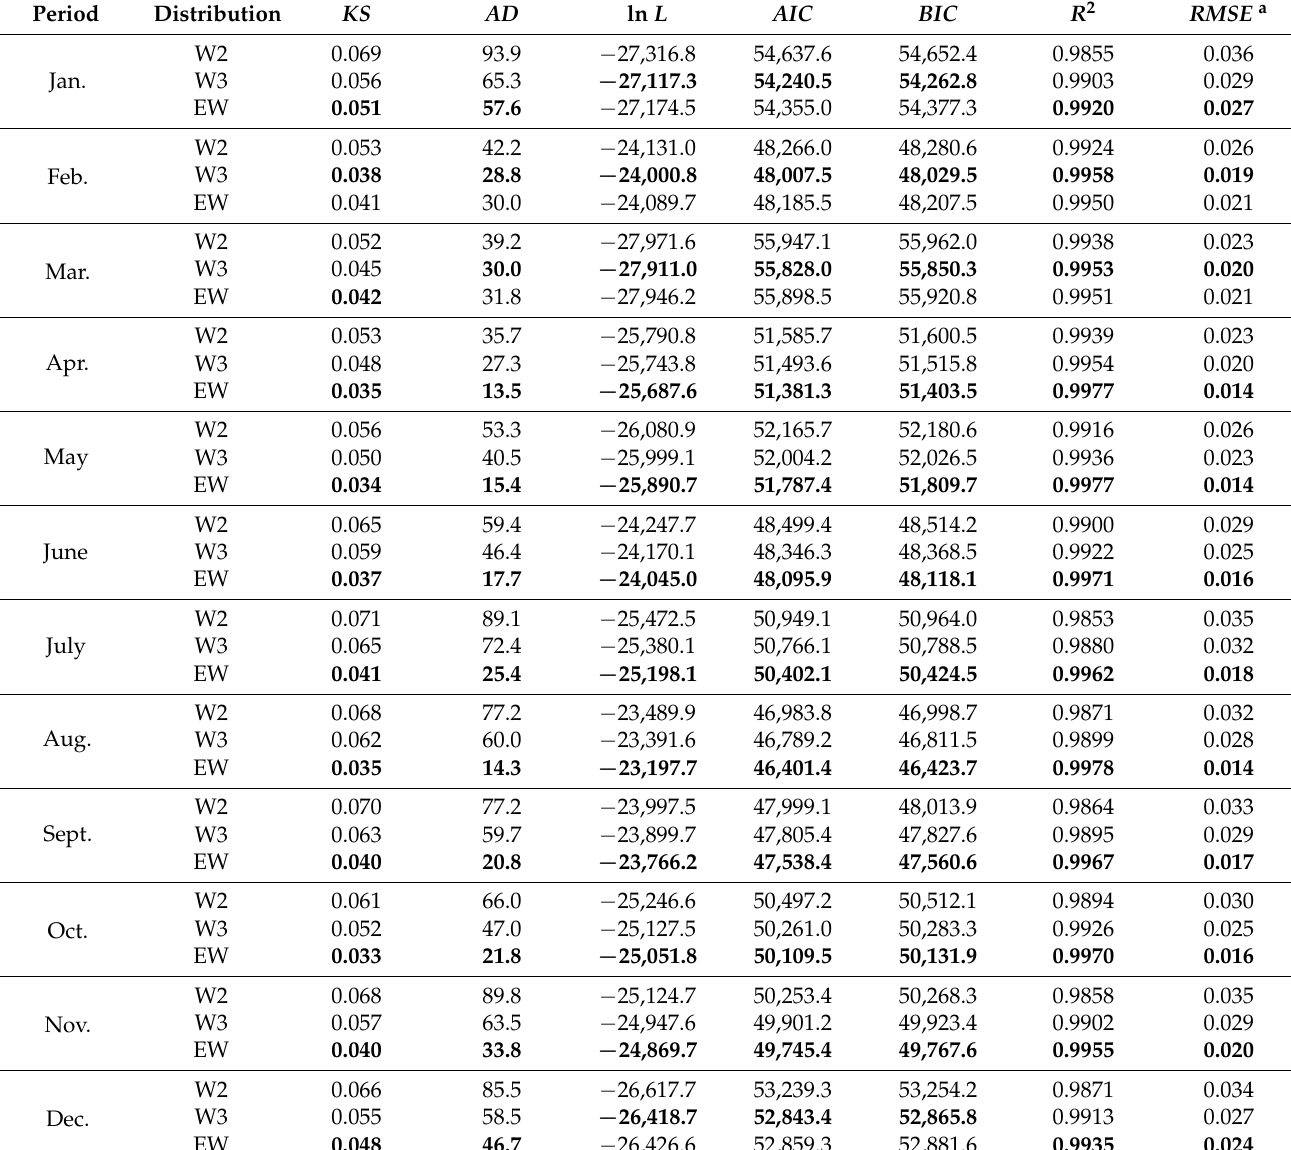
Table 8. The GOF tests and model selection criteria for the respective